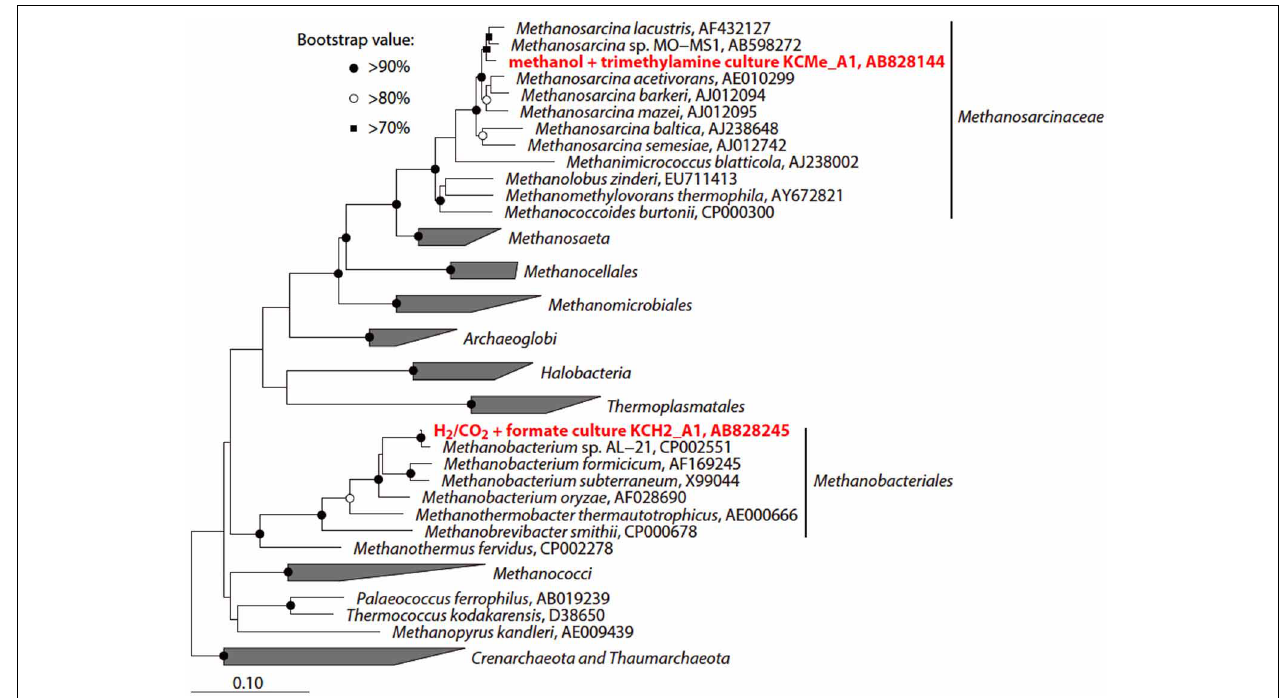
FIGURE 8 | Phylogenetic tree showing the position of 16S rRNA gene sequences obtained from the methanogenic enrichment cultures. The initial tree was constructed with sequences greater than 1000 nucleotides using the neighbor-joining method. Subsequently, the sequences obtained in this study were inserted into the tree by the